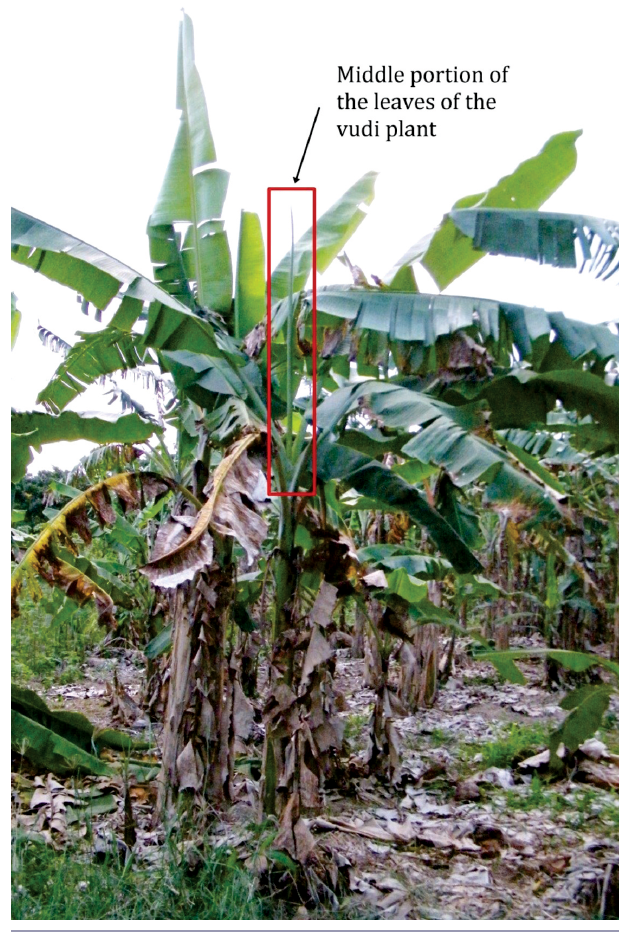
Fig. 2 . Photograph of a vudi ( Musa balbisiana ) plant showing the leaves that indicate the likelihood of bad weather if not growing